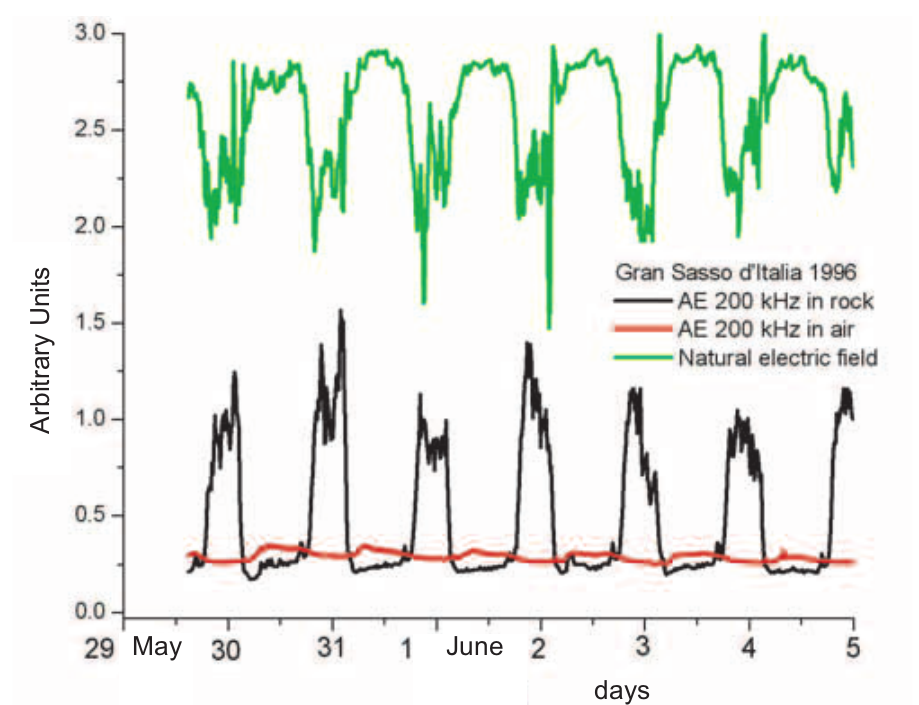
Fig. 1. Records in the Gran Sasso area, May 29 through June 5, 1996, showing AE at 200 kHz both inside rock (lower black) and in air (blank signal, lower light grey) and the natural electric field (upper plot) recorded by metal rod inserted into ground for ~ 12 m (in co-operation with INGV) and used as a receiving antenna tuned on the same